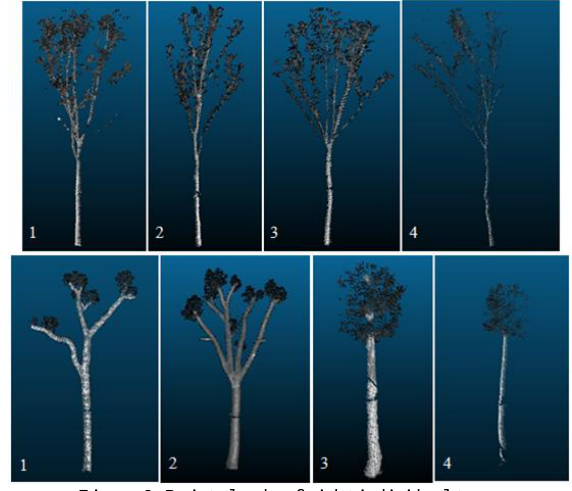
Figure 2. Point clouds of eight individual